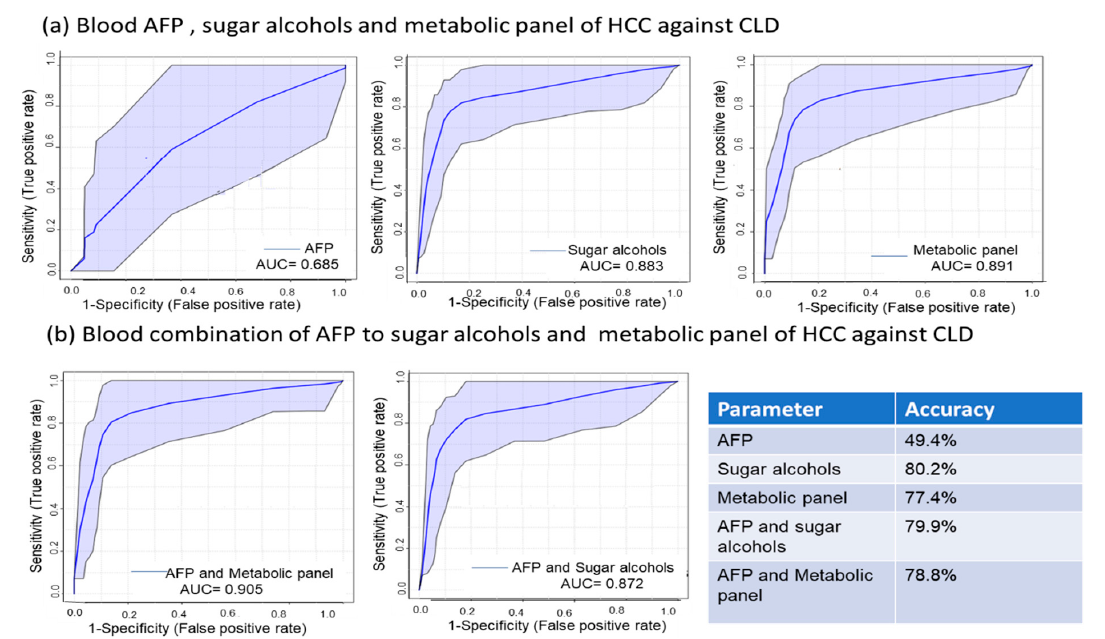
Figure 6. Receiver operating characteristic (ROC) curve analysis of a 6-metabolite panel of Figure6. Receiveroperatingcharacteristic(ROC)curveanalysisofa6-metabolitepanelofdiscriminating discriminating metabolites, a panel of blood sugar alcohols, and AFP to differentiate HCC from metabolites, a panel of blood sugar alcohols, and AFP to di ff erentiate HCC from chronic liver disease chronic liver disease (CLD). ( a ) ROC curve of AFP, 6-metabolite panel, and sugar alcohols to (CLD). ( a ) ROC curve of AFP, 6-metabolite panel, and sugar alcohols to di ff erentiate HCC from CLD differentiate HCC from CLD and associated accuracy of each comparison. ( b ) ROC curve of combined and associated accuracy of each comparison. ( b ) ROC curve of combined AFP with the 6-metabolite AFP with the 6-metabolite panel, and sugar alcohols to differentiate HCC from CLD and associated panel, and sugar alcohols to di ff erentiate HCC from CLD and associated accuracy of each accuracy of each comparison.